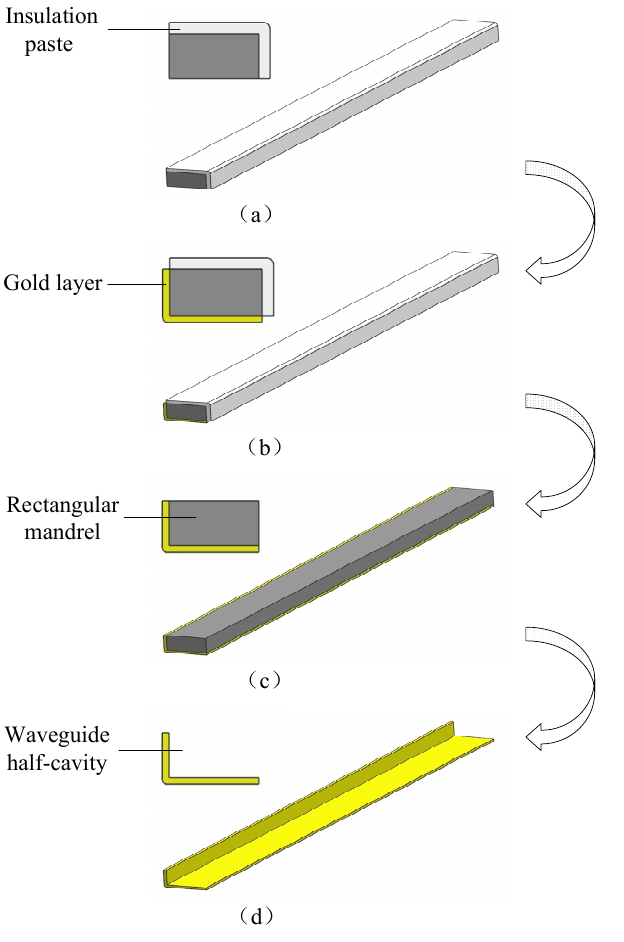
Figure 13. The manufacturing process of the open-type waveguide half-cavity: ( a ) local insulation of rectangular mandrel, ( b ) gold electroplating on non-insulated surface of the rectangular mandrel, ( c ) removal of the insulation paste, and ( d ) selective chemical dissolution of rectangular mandrel.